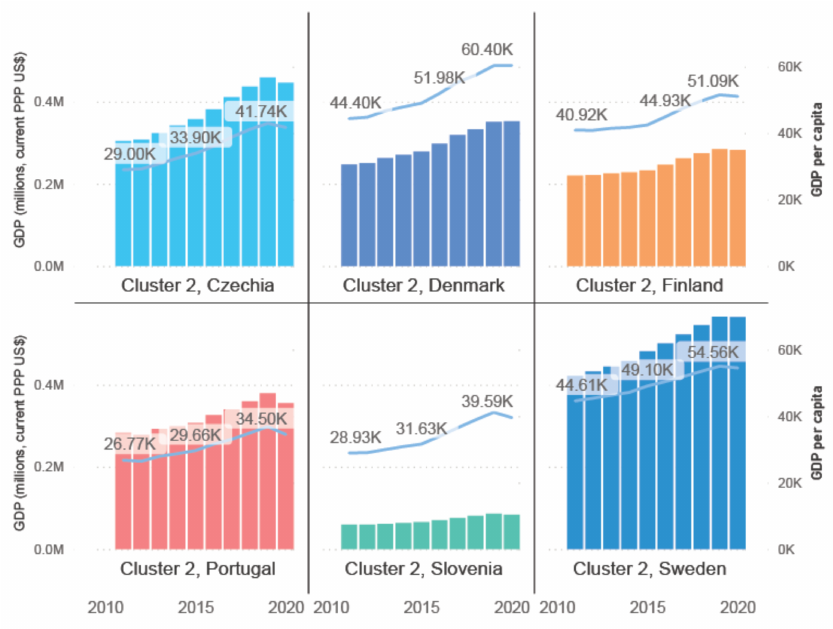
Figure 16. GDP and GDP per capita for the cluster of highly robotized countries. Source: Author’s contri- bution based on data retrieved from International Comparison Program, World Bank, World Development Indicators database, World Bank|Eurostat-OECD PPP Programme. Available at: https://data.worldbank. org/indicator/NY.GDP.PCAP.PP.CD and https://data.worldbank.org/indicator/NY.GDP.MKTP.PP.CD, accessed on 10 March